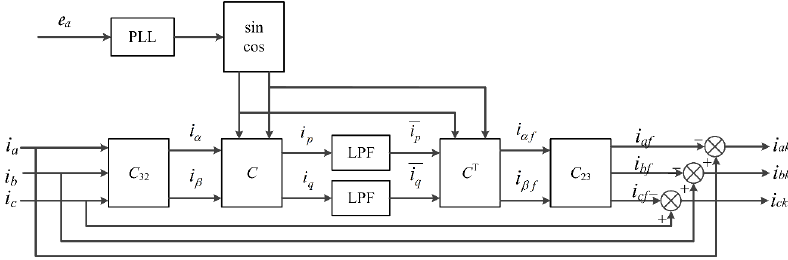
Figure 3. The method of current detection based on i p - i q principle.